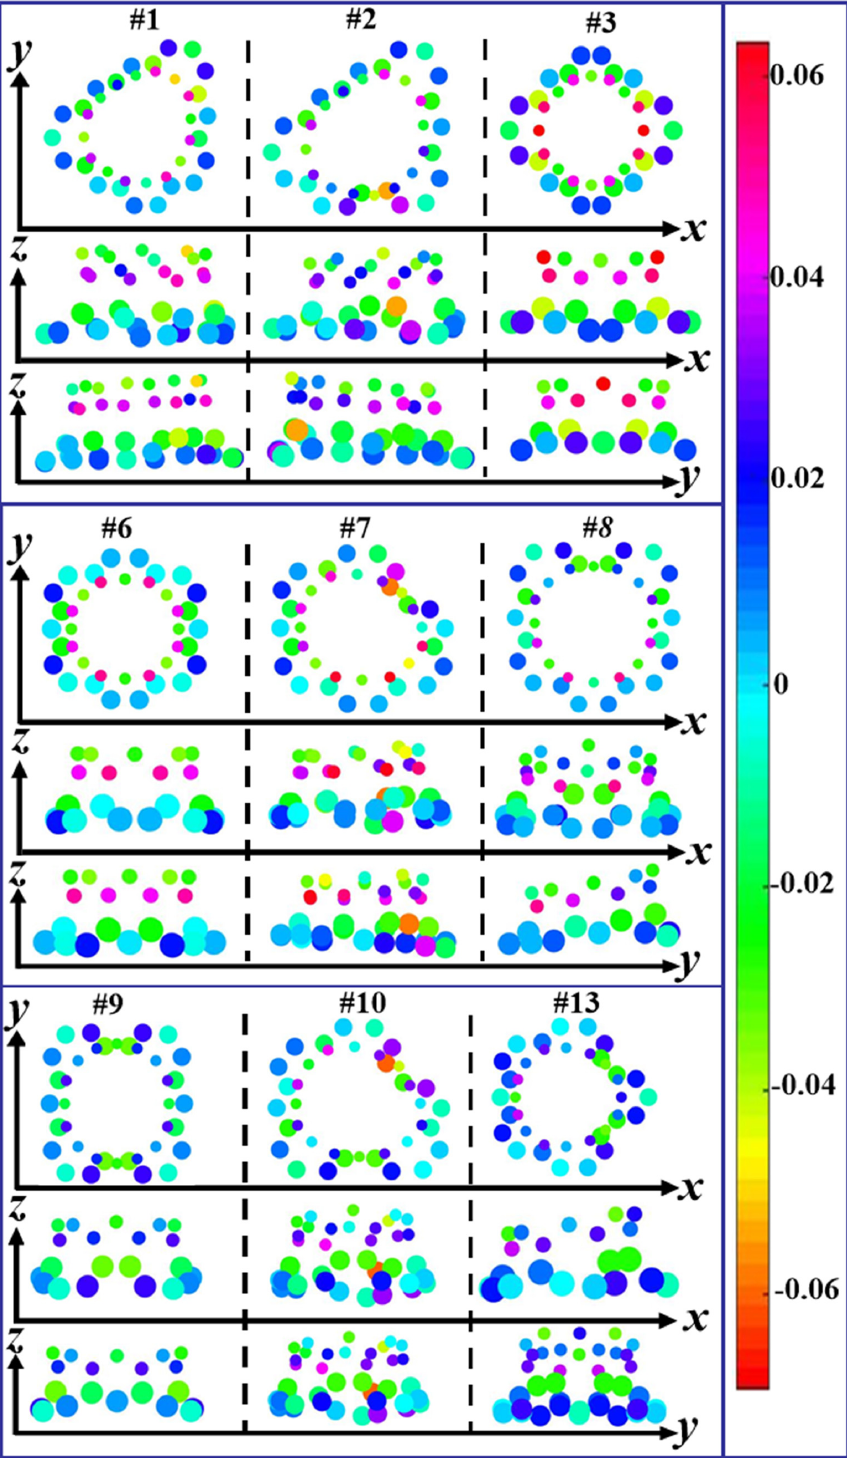
Figure 9. The Mülliken charge near around the connection knots of (8,0)CNT96-graphene by these seamless links.